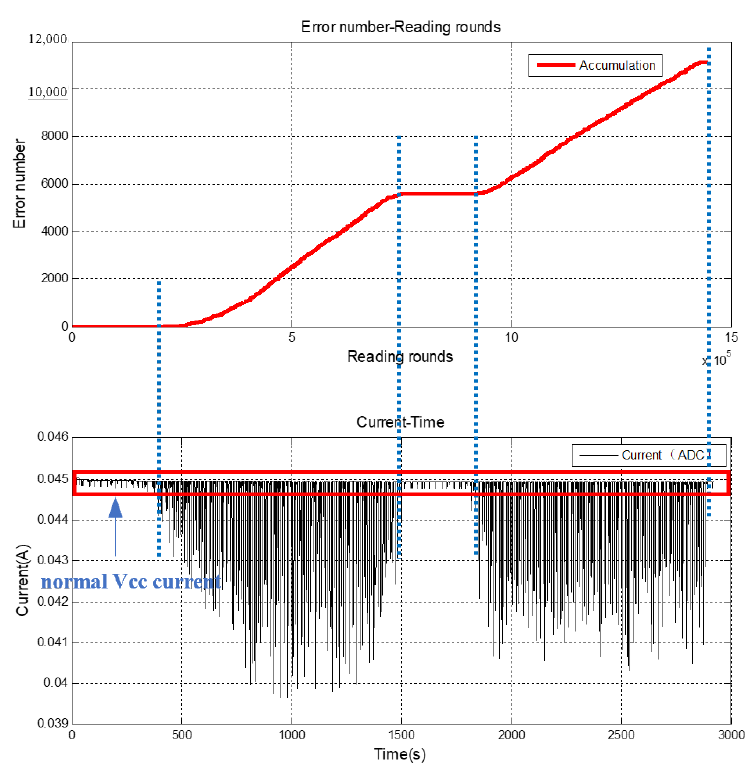
Figure 10. The comparison of error number and